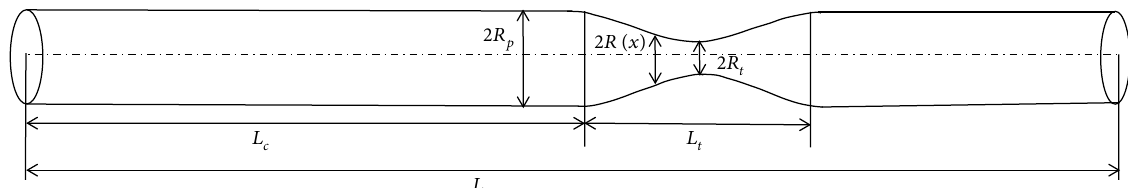
Figure 3: Structural schematic of pore and throat in the capillary